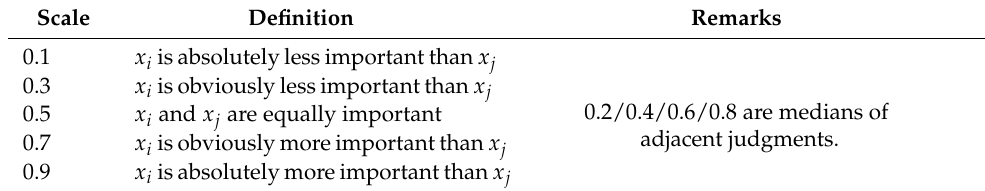
Table 3. Fuzzy complementary scale